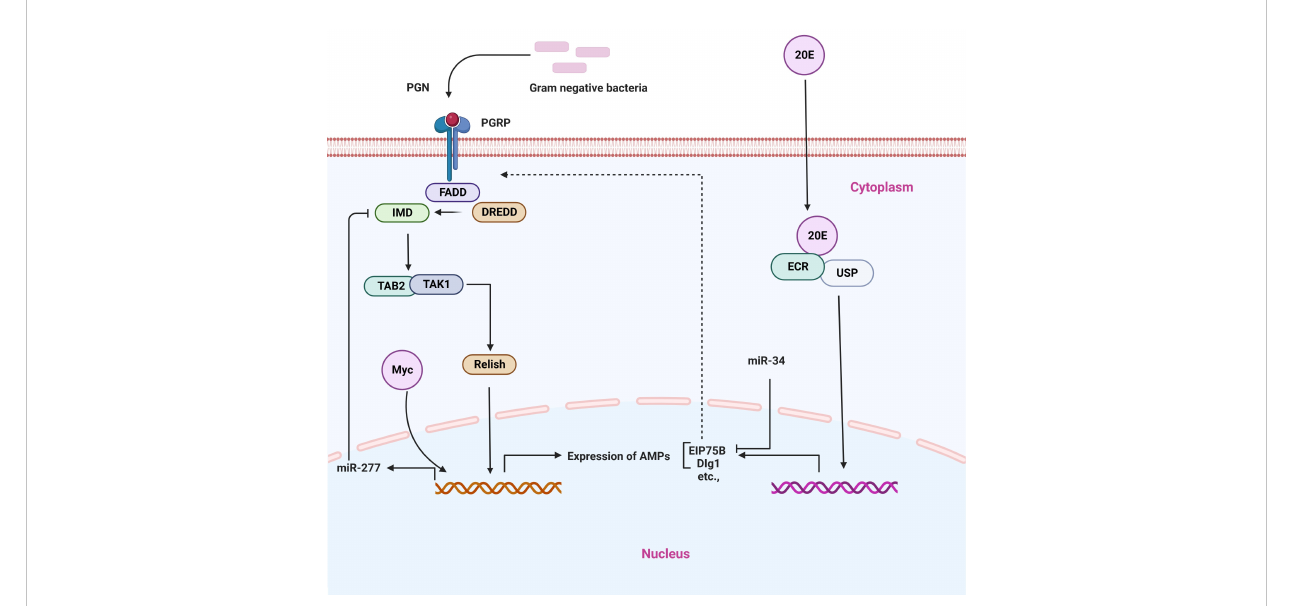
FIGURE 5 Representative microRNAs in the regulation of IMD signaling pathway. PGRP receptor recognizes different bacterial components and activates the downstream signaling